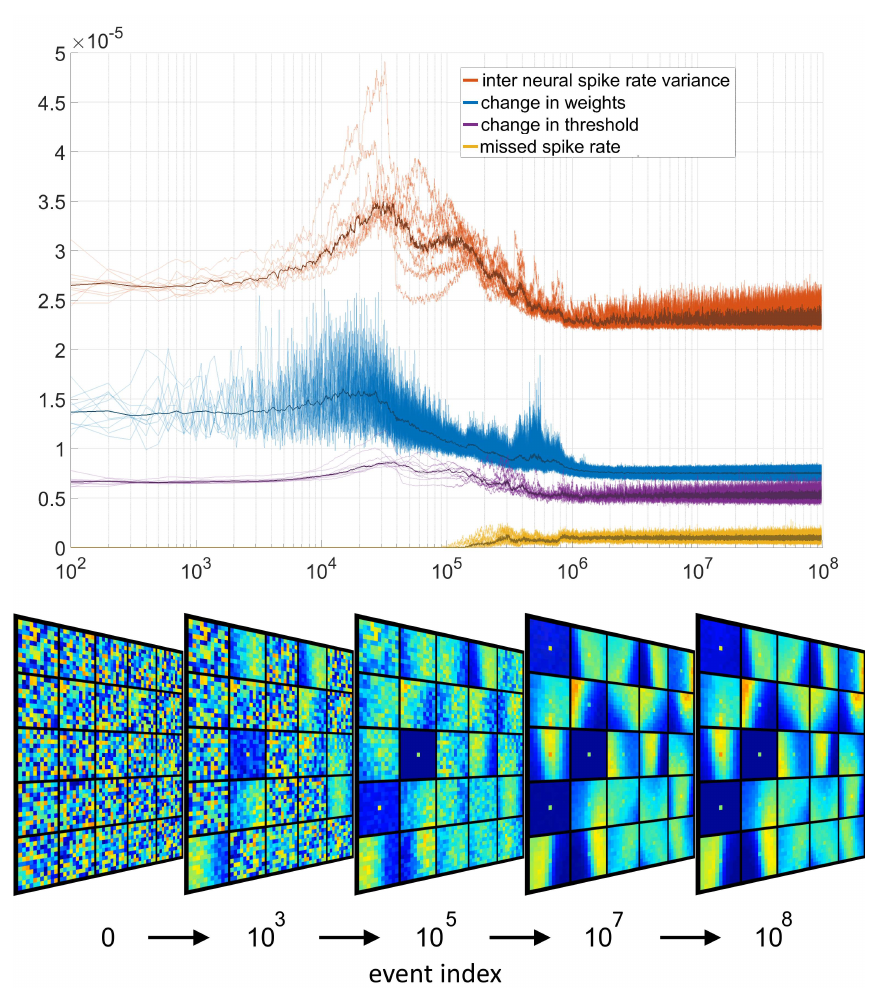
Figure 3. Evolution of the network variables. Top panel shows the adaptation of various neural signals in the network over 10 independent trials as well as the mean over the trials. Every 100 events four signals were sampled and and the magnitude of their inter-sample change is plotted over input event index. The signals plotted include the variance (across neurons) of the output spike rate (divided by ten thousand), the magnitude of the change in the synaptic weights of all neurons, the magnitude of the change of the selection thresholds and the missed spike rate (divided by ten thousand). The bottom panel shows the evolution of the feature weights for one of the trials. Note the presence of three variants of the “noise feature” in the feature sets. These empty features with a single high value at the central triggering pixel are learnt from events which are not correlated with any recent adjacent events. While the features appear empty and flat except for the central pixel, all but one feature per network typically exhibit very weak structure in their “empty” regions distinguishing them from each other and the dominant truly flat noise